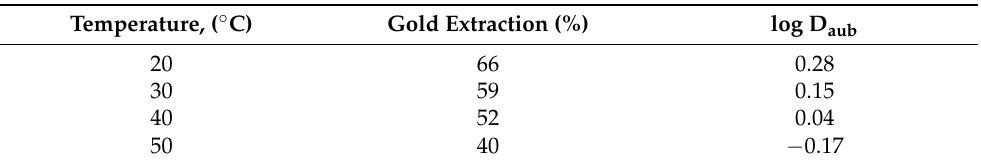
Table 1. Influence of the temperature on gold extraction.